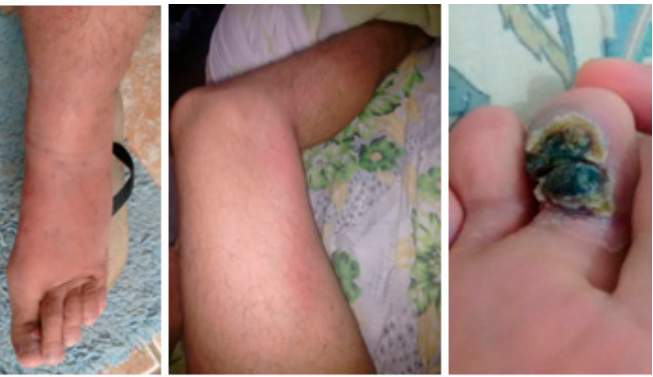
Figure 1. Initial presentation of verrucous lesions, erythematous cord, and edema. These pictures were taken by the patient 12 months before looking for an